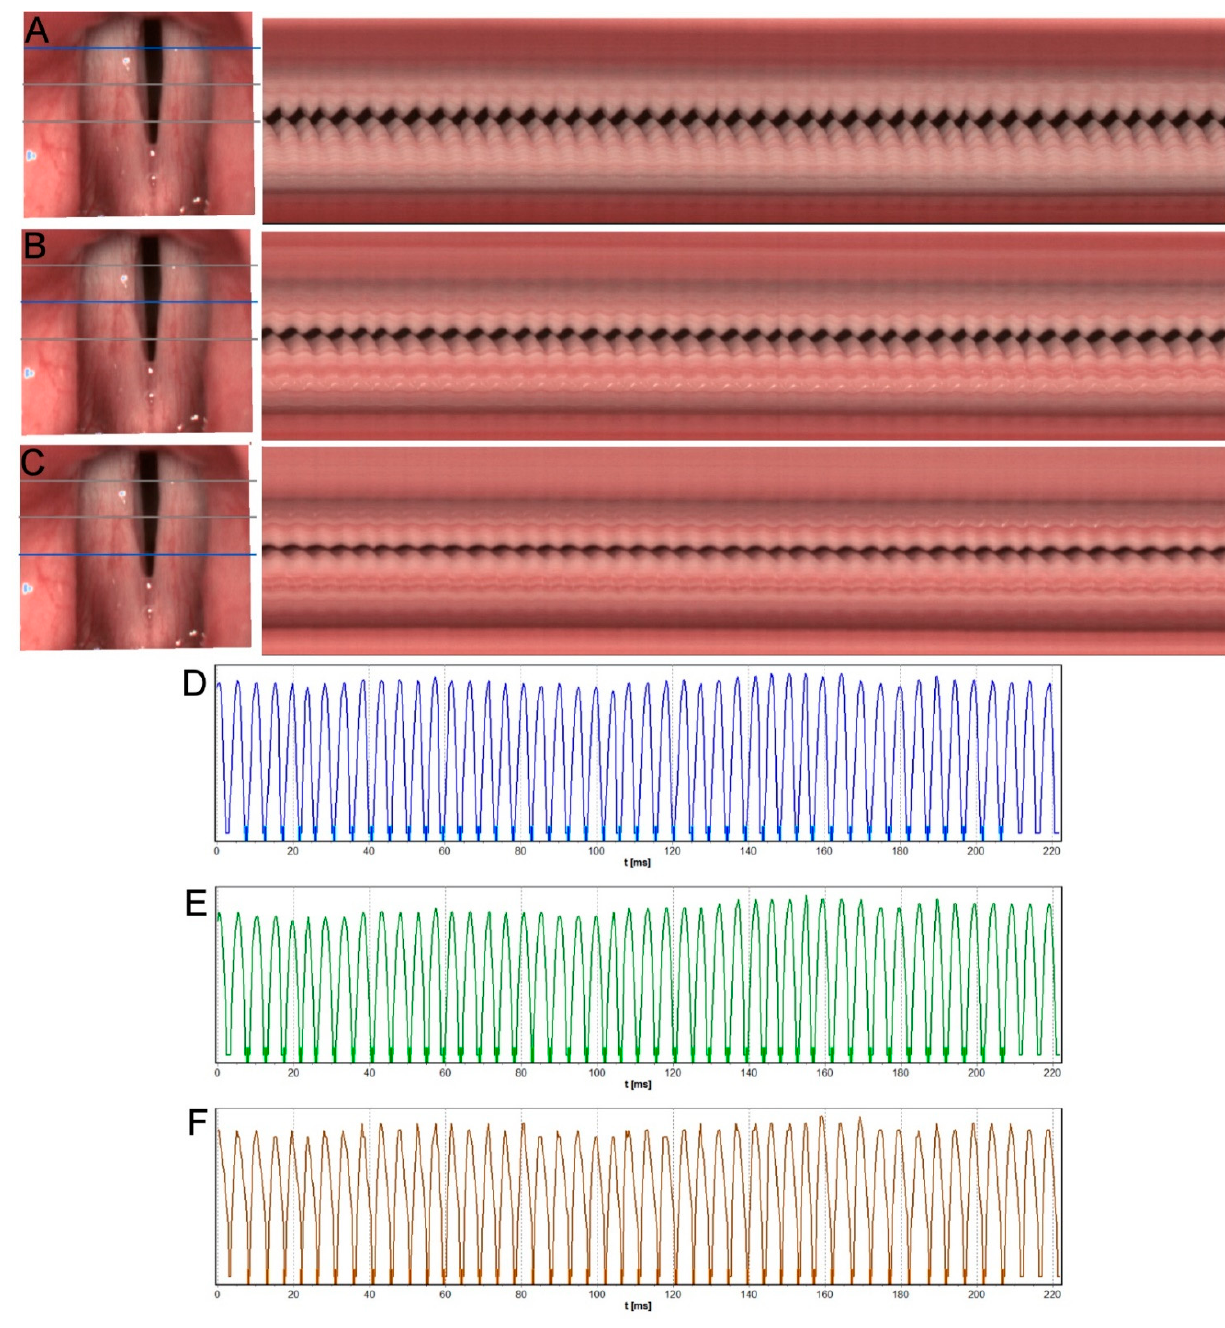
Figure 5. Images of the glottis for Subject 2 after treatment, obtained by HSV recording. ( A – C )—on the left: rotated images of vocal folds with grey lines marking three cross-sections used for generating videokymograms. On the right: long videokymograms obtained for cross-sections marked with a blue line. Respectively: ( A )—posterior, ( B )—middle, ( C )—anterior part of the glottis. ( D – F )—Glottal Width Waveform (GWW) plots obtained from corresponding videokymograms: the posterior, middle, and anterior sections of the glottis,